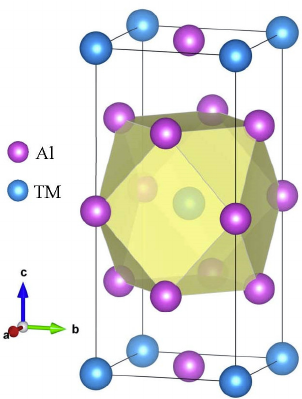
Figure 1. The crystal structure of D0 22 -type Al 3 TM compounds.